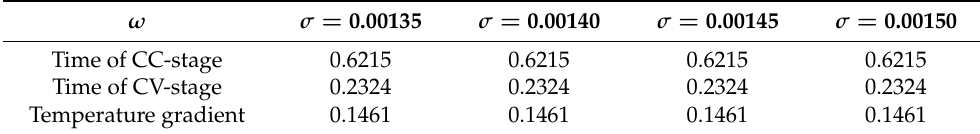
Table 5. Reliability of different perturbation intensities.